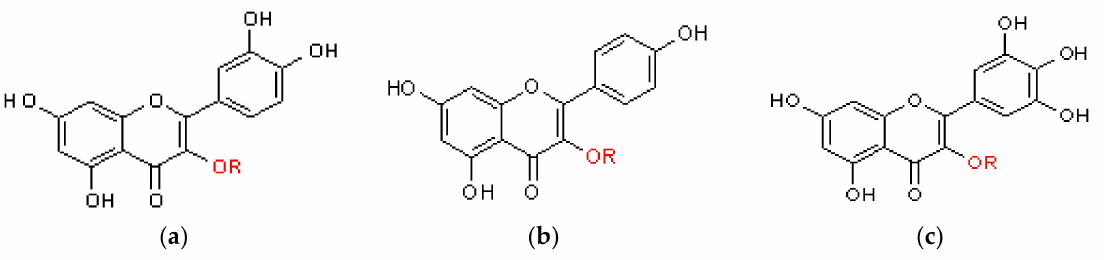
Figure 3. General structure of flavonols ( a ) quercetin, ( b ) kaempferol, and ( c ) myricetin; R—glycoside